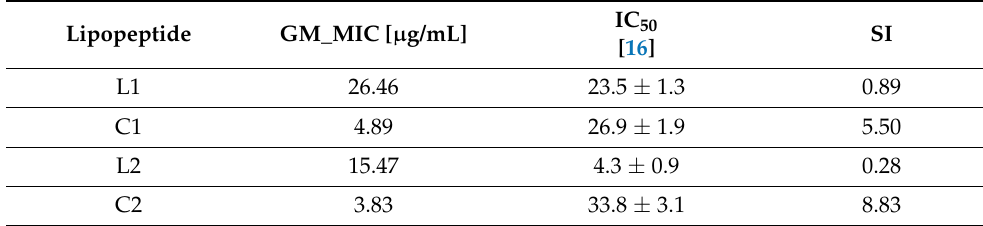
tested lipopeptides.